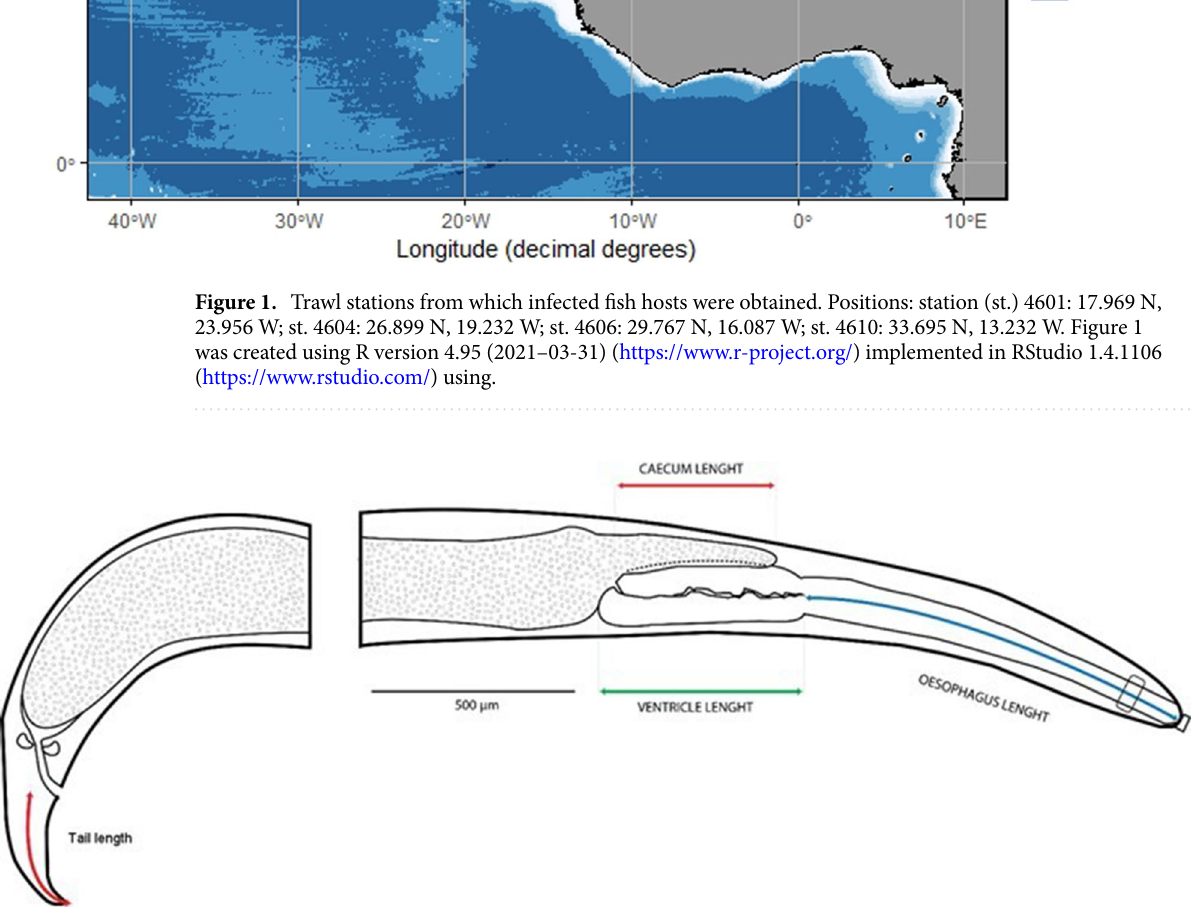
Figure 2. Measurements taken from the images of Terranova -like larvae. The oesophagus length is taken along the midline from the start of the oesophagus (i. e. slightly sub-terminally in the roundworm) to the ventricle. The caecum length was measured from the aperture into the ventricle to the caecum end. The tail length represents the distance along the midline, from the level of the anus/cloaca to the posterior end. Figure 2 was created in Adobe Photoshop 23.5.0 (https:// www. adobe. com/ photo